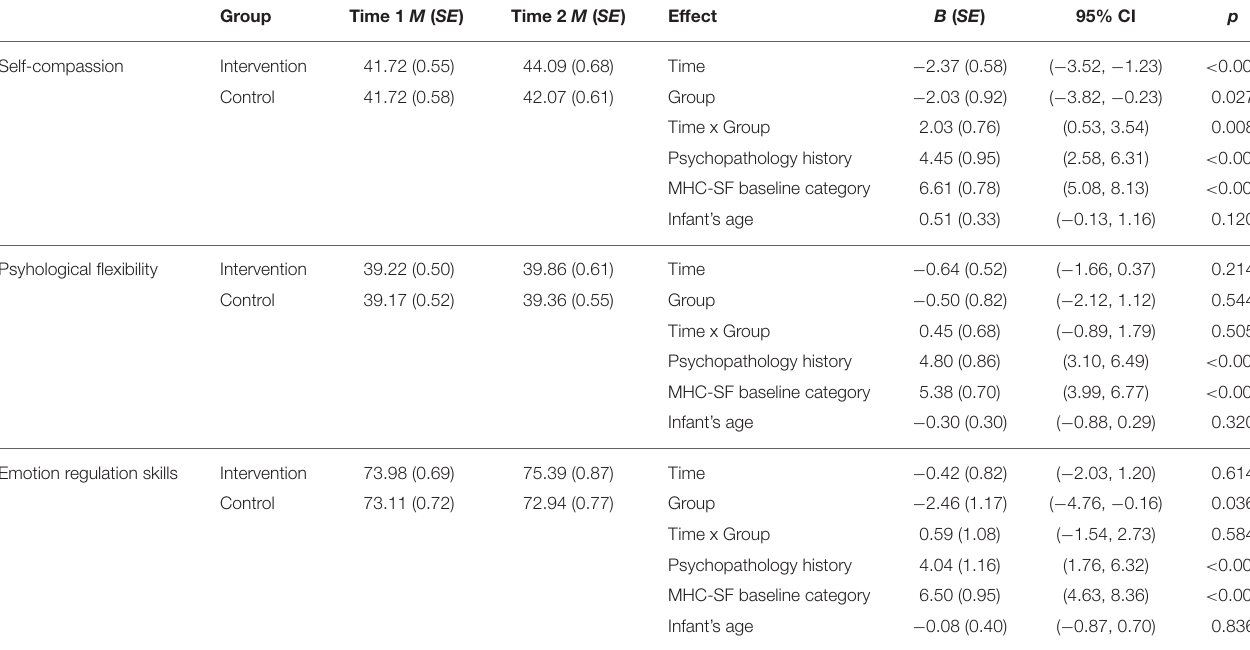
MHC-SF, mental health continuum-short form.